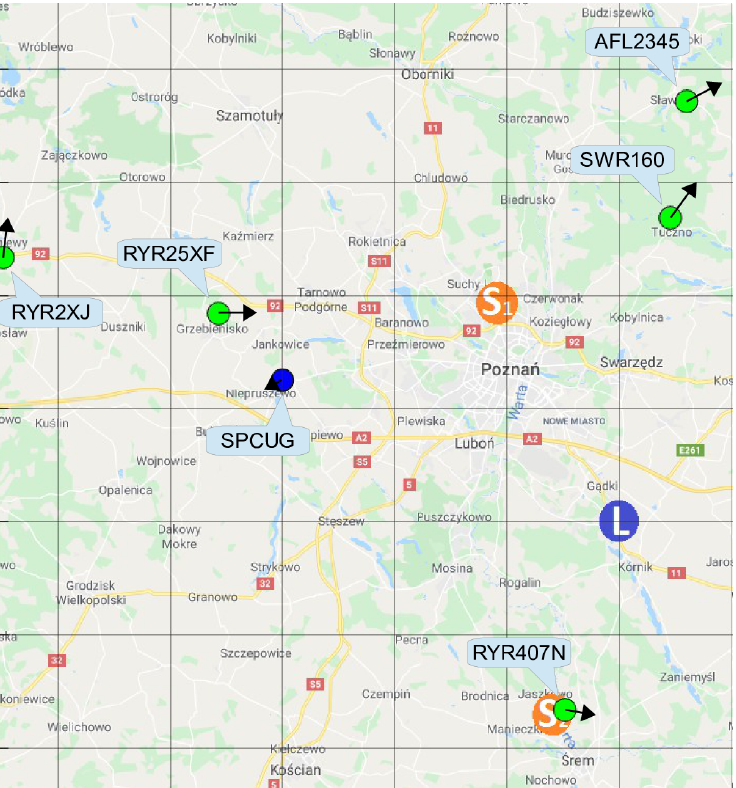
Figure 19. Map with planes around the LOFAR station in Borowiec at the moment of the registration, L —the LOFAR station in Borowiec, S 1 —the broadcasting station in Piatkowo, S 2 —the broadcasting station in